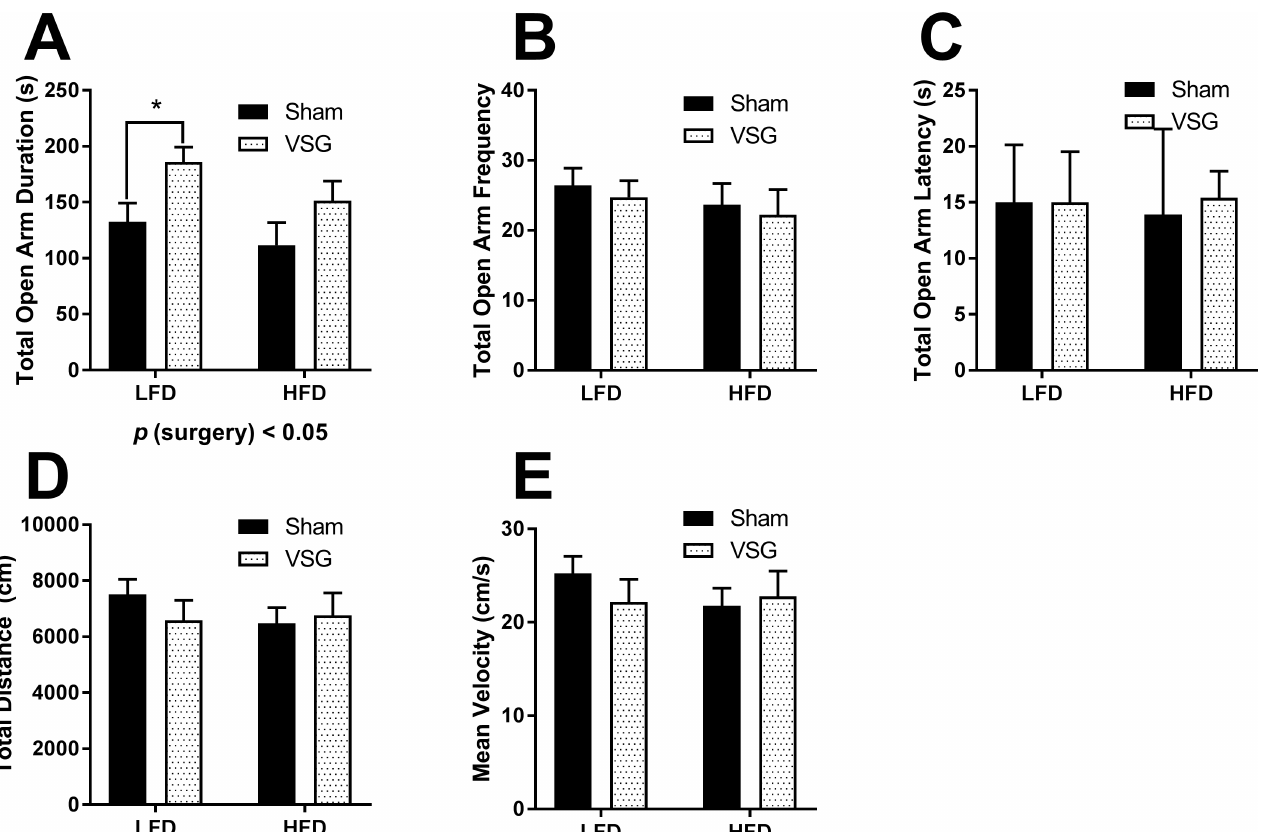
Fig 3. Behavioral analysis of female rats in elevated plus maze. (A) Total duration (s) of time spent in the open arms (B) Frequency of entries into the open arms (C) Latency to entry of the open arm (D) Total distance travelled during the EPM (cm) (E) Mean velocity in cm/s. Data are presented as mean ± SEM. N = 5-7/group. (cid:3) p < 0.05, (cid:3)(cid:3) p < 0.01. (cid:3)(cid:3)(cid:3) p < 0.001.